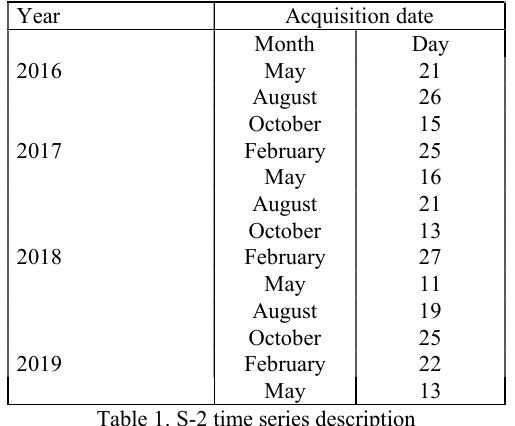
Table 1. S-2 time series description